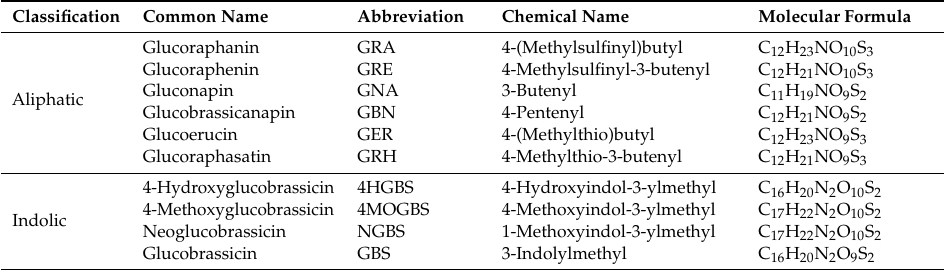
Table 1. Properties of GSLs found in radish